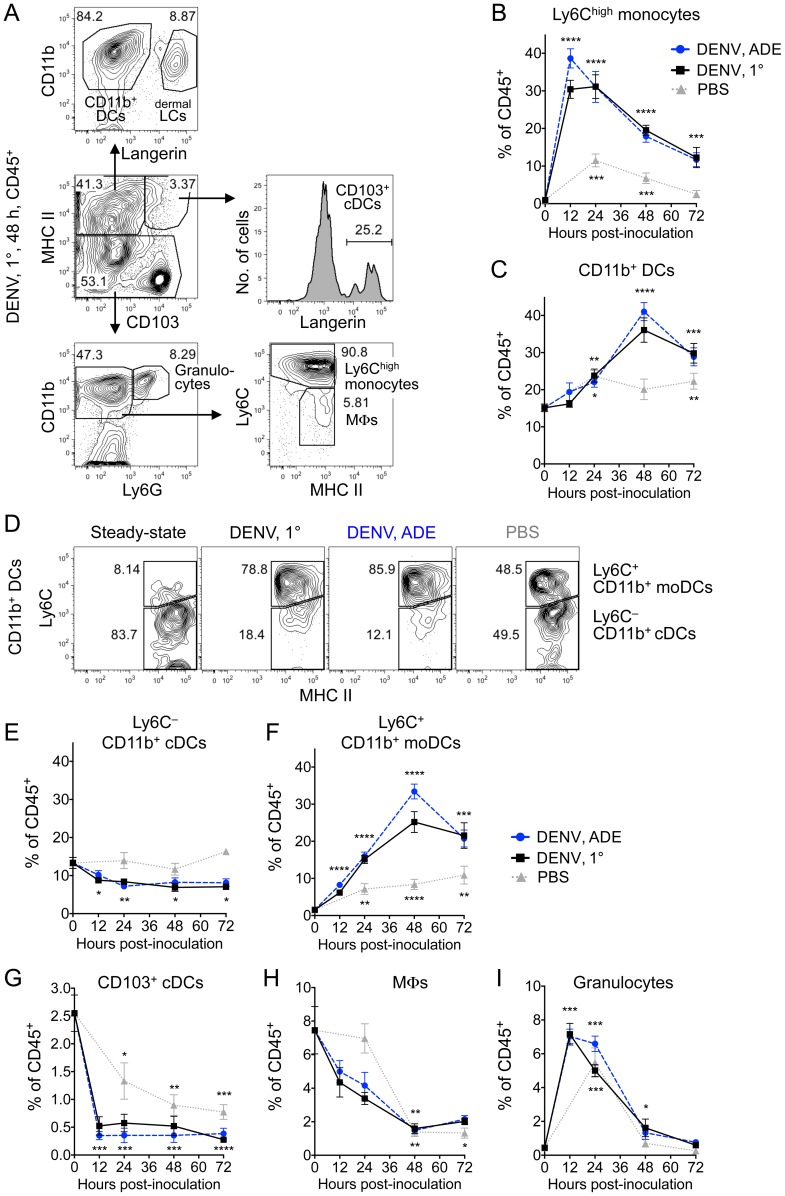
Dynamics of cell populations in the DENV-infected dermis.(A) Gating of cell populations in the dermis in Ifnar
–/– mice 48 hpi with DENV2 under 1° infection conditions. (B and C) Time-courses showing mean ±SEM of % Ly6Chigh monocytes (B) and CD11b+ DCs (C) among dermal CD45+ cells after i.d. inoculation with DENV2 under 1° (black square) or ADE (blue circle) infection conditions or after inoculation with PBS (grey triangle). Time-point “0” is the frequency of each cell type in steady-state untouched dermis (data from Fig. 1). (D) Ly6C expression separating CD11b+ DCs into Ly6C+ CD11b+ moDCs and Ly6C– CD11b+ cDCs in the steady-state dermis, or 48 hpi with DENV2 or PBS. (E–I) Time-courses showing mean ±SEM of % Ly6C– CD11b+ cDCs (E), Ly6C+ CD11b+ moDCs (F), CD103+ cDCs (G), MΦs (H), and granulocytes (I) among dermal CD45+ cells. Significant differences between cell frequencies in steady state and after i.d. inoculation are marked as * for p≤0.05; **, p≤0.01; ***, p≤0.001; and ****, p≤0.0001. Asterisks designate p-values comparing steady state to 1° or ADE DENV2 infection together as they were similar. Representative plots or pooled data are from 2–4 independent experiments (n = 6–10 per time-point and condition). See also Figure S4.